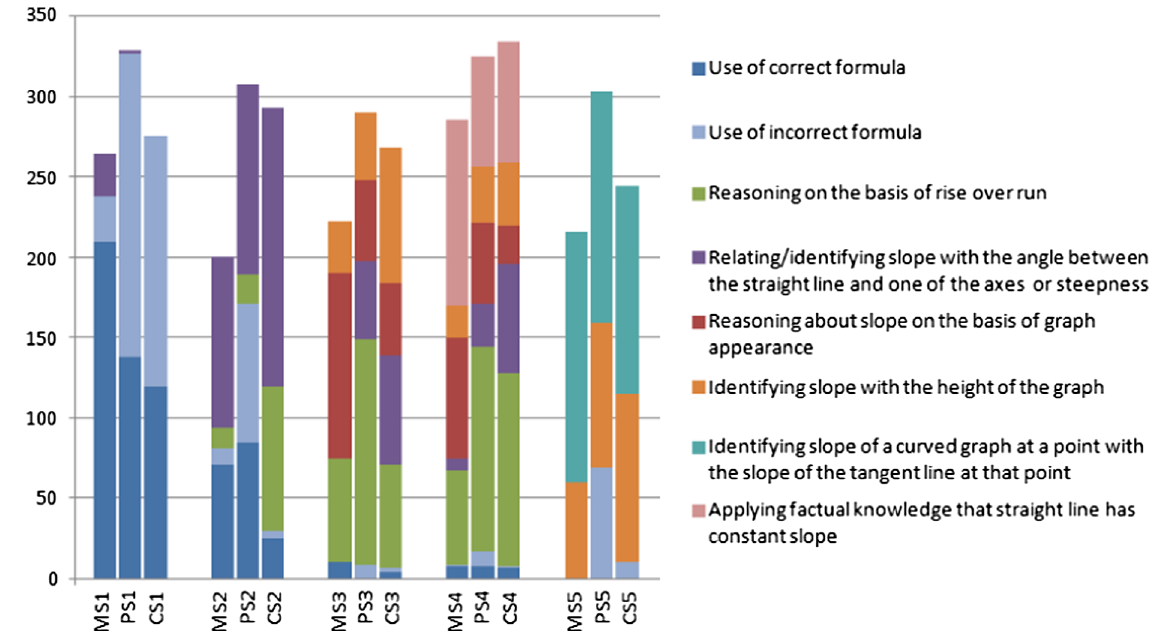
FIG. 2. Overview of different strategies on slope questions and their frequencies (the number of students who used